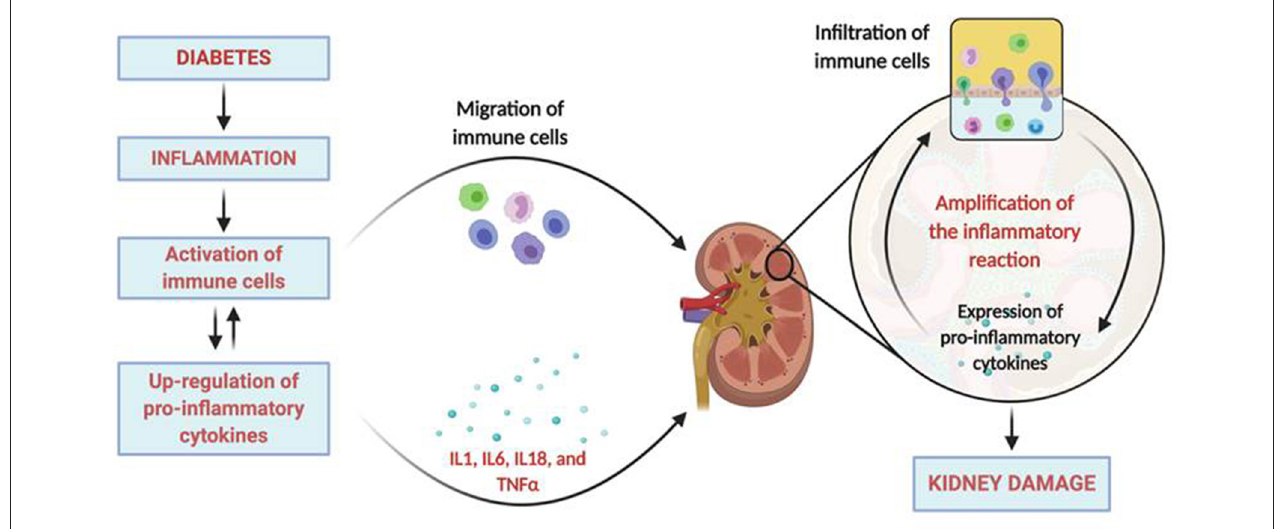
FIGURE 1 | Inflammatory pathophysiology in diabetic kidney disease. The diabetic milieu drives to the development of inflammation that includes the activation of immune cells and the upregulation of pro-inflammatory cytokines. Activated immune cells migrates and infiltrates the renal tissue locally producing more inflammatory mediators and chemokines that recruit more immune cells into the kidney. Moreover, activated resident renal cells can also produce additional proinflammatory mediators, contributing to sustained inflammation, and the induction of kidney damage. Created with BioRender.com.